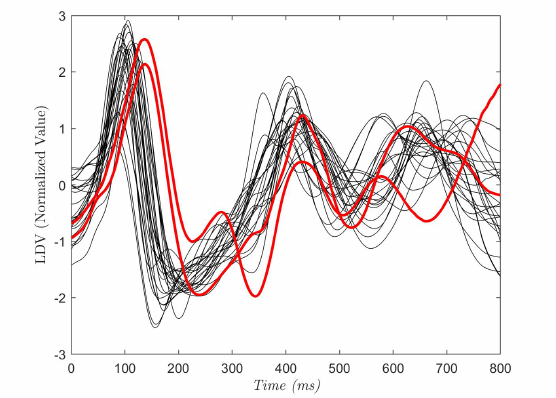
Figure 6. Each curve refers to one subject and is the average of a portion of the LDV signal. The portion starts from the R peak in the ECG and last 800 ms. The red curves refer to the subjects with the lowest AUC